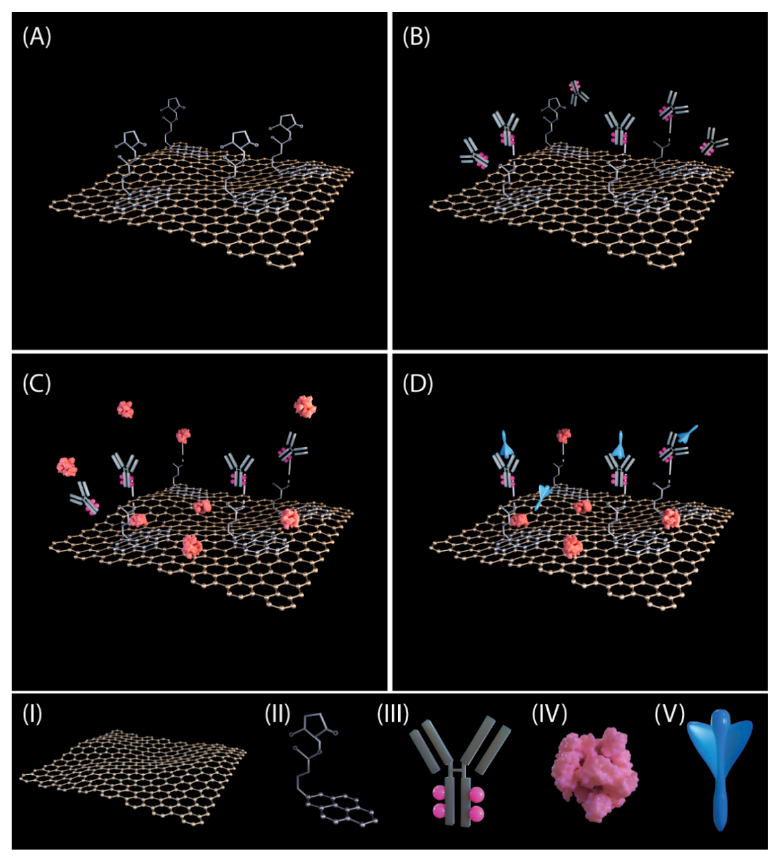
Figure 1. Schematics of functionalization and the concept of detection. ( A ) The graphene working electrode is functionalized with 1 ‐ pyrene butyric acid N ‐ hydroxysuccinimide ester (PBASE) linker. ( B ) The spike ‐ specific antibodies are immobilized to the electrode using the linkers. ( C ) Bovine Serum Albumin (BSA) is used to block free surface or linkers on the electrode. ( D ) Upon addition of the sample, only the spike protein will attach to the antibodies. ( I ) Graphene lattice; ( II ) 1 ‐ Pyrenebutyric acid N ‐ hydroxysuccinimide ester (PBASE) linker; ( III ) spike ‐ specific antibody; ( IV ) Bovine serum albumin (BSA) protein; ( V ) SARS ‐ CoV ‐ 2 spike subunit 1 protein.